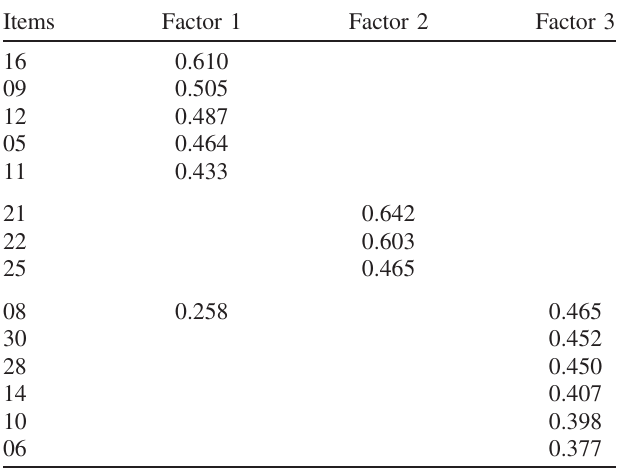
TABLE IV. Initial three-factor loadings for group B. Loadings less than 0.25 have been suppressed. EFA involved approxi- mately half of the section 1 students. These loadings represent results after a filtering of the original 30 items.